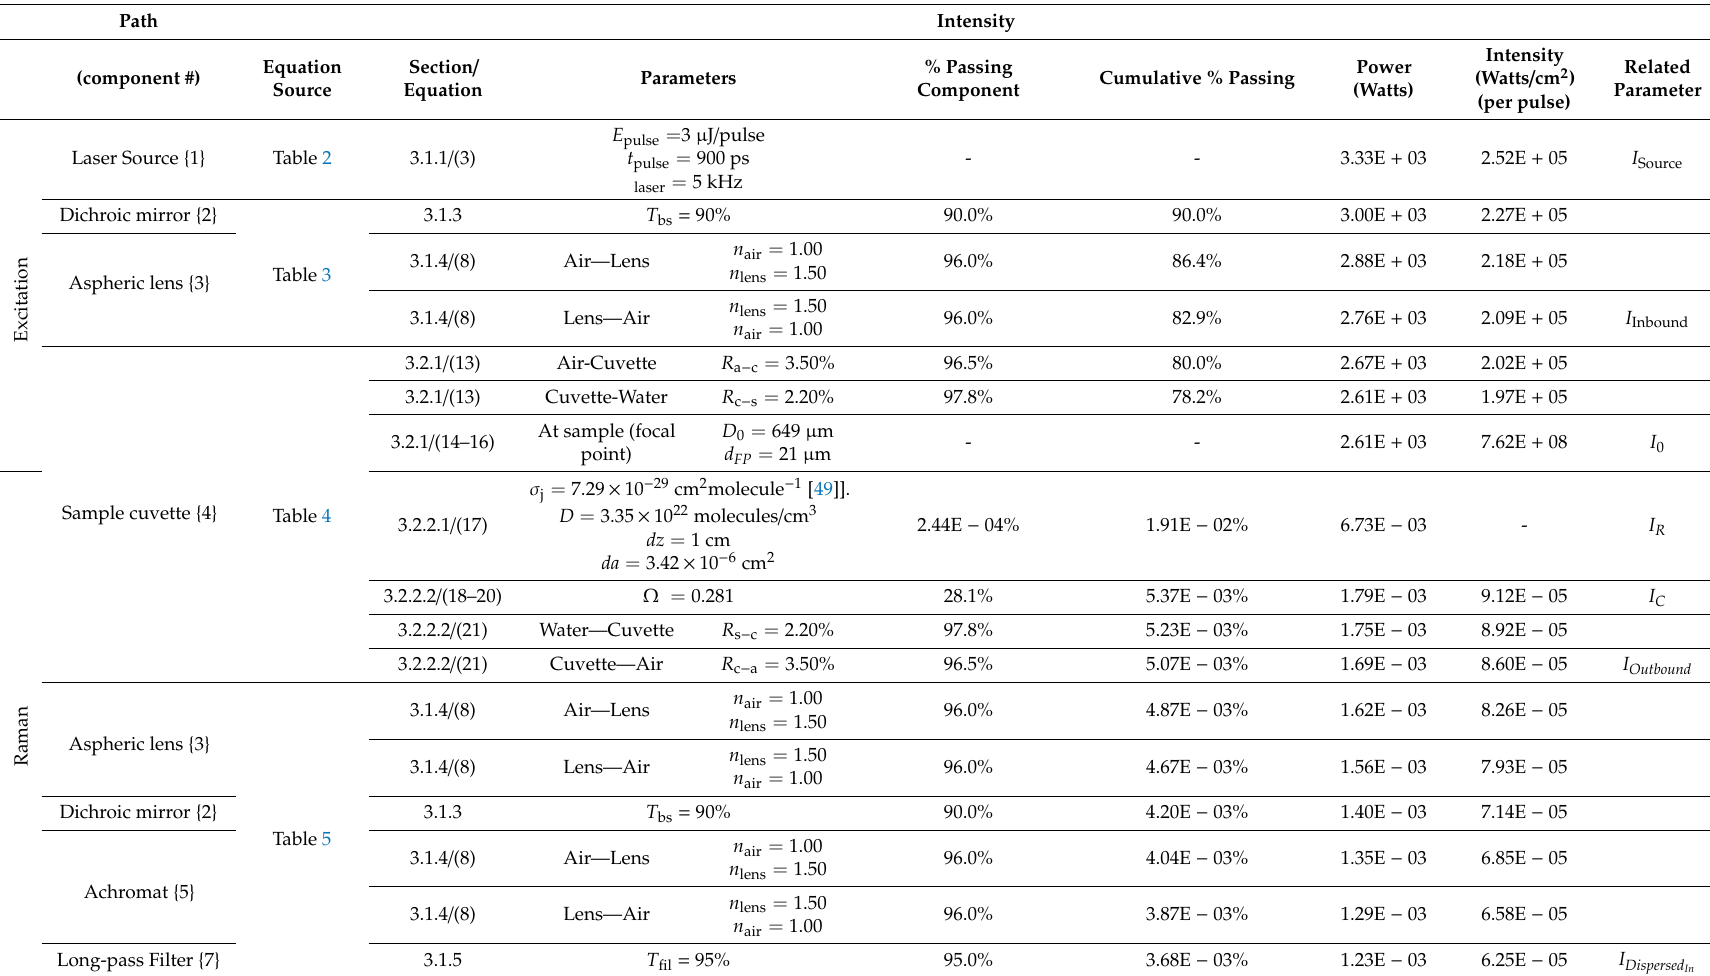
Table 7. Purdue CE Spectroscopy Lab 532 nm open-path TRRS example intensity